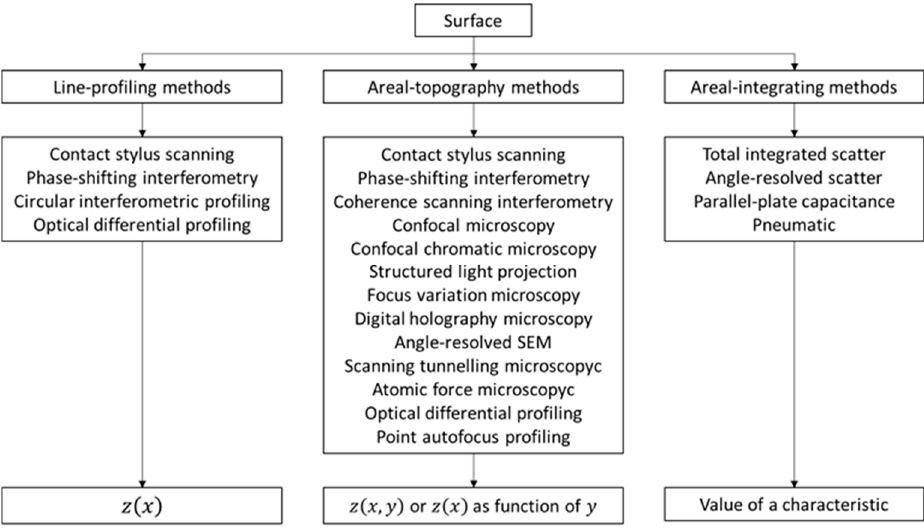
Figure 1. Surface characterization methods [10,11].